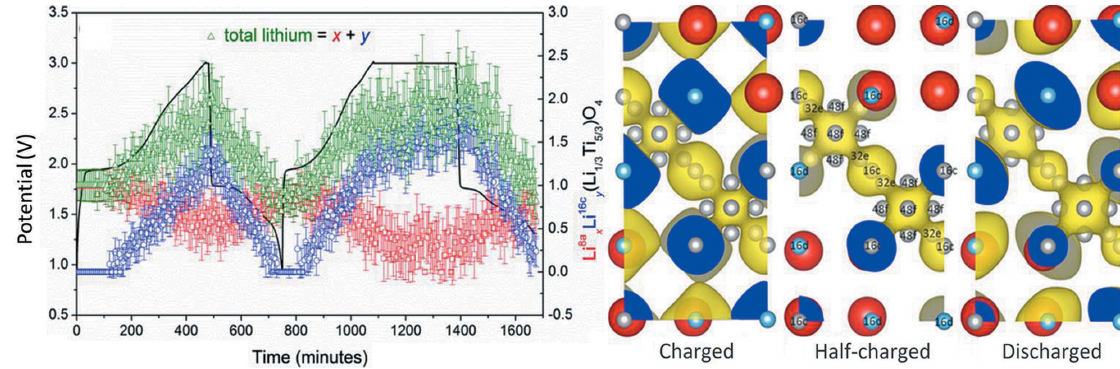
Figure 10 (Left) Li site occupancy at the 8 a and 16 c sites for Li 4 Ti 5 O 12 during cycling. (Right) The nuclear density arising from Li (yellow; O is red and Ti is blue) at particular crystallographic sites (labelled, grey) within the structure, shown for the material within the battery at the charged, half-charged and discharged states. Adapted from Pang, Peterson et al.